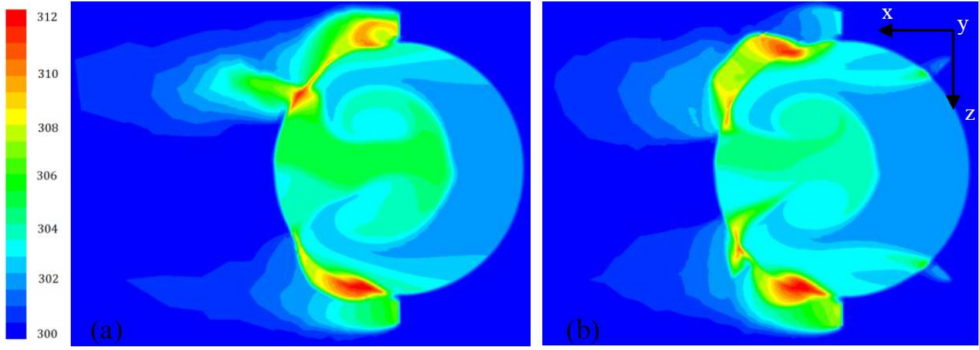
Figure 18. Temperature contours at the tower inlet (unit: K). ( a ) 4 deflectors, ( b ) 8